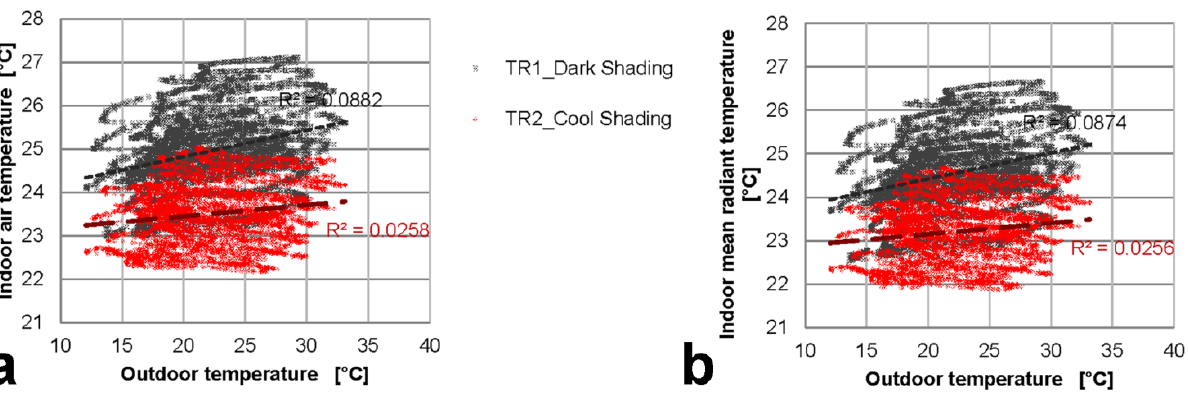
Figure 9. Indoor thermal comparative assessment of the two configurations in terms of ( a ) air temperature and ( b ) mean radiant temperature, in free floating